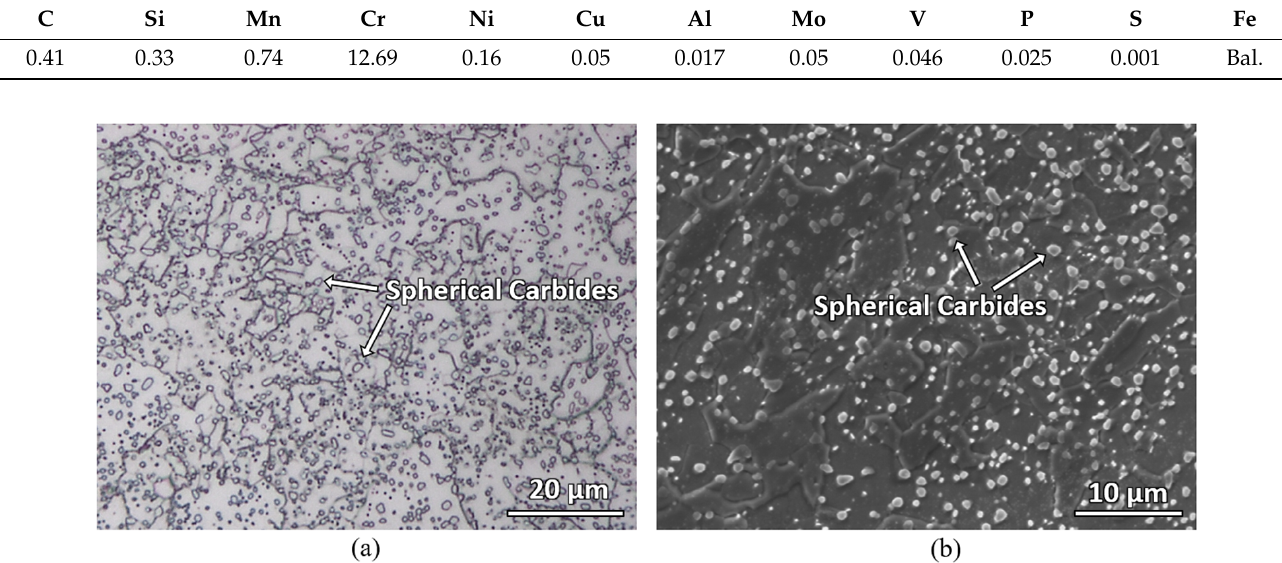
Figure 1. ( a ) Optical micrograph and ( b ) secondary electron micrograph of the as-received AISI 420 martensitic stainless steel showing spherical carbides distributed randomly in the matrix.